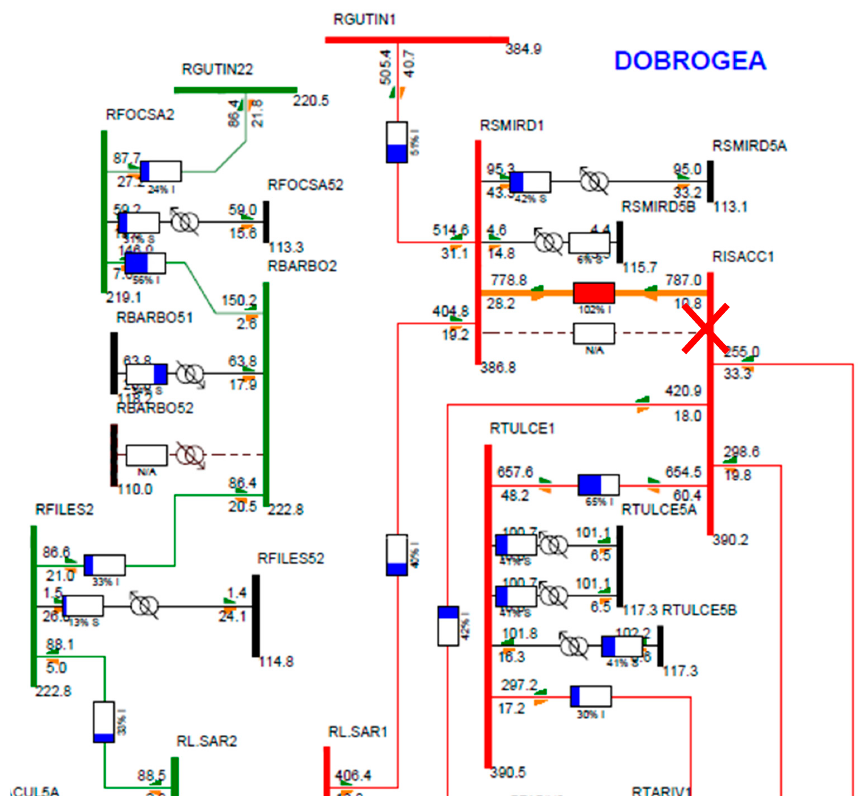
Figure 6. Unavailability of a 400 kV line determining the overloading of other lines.